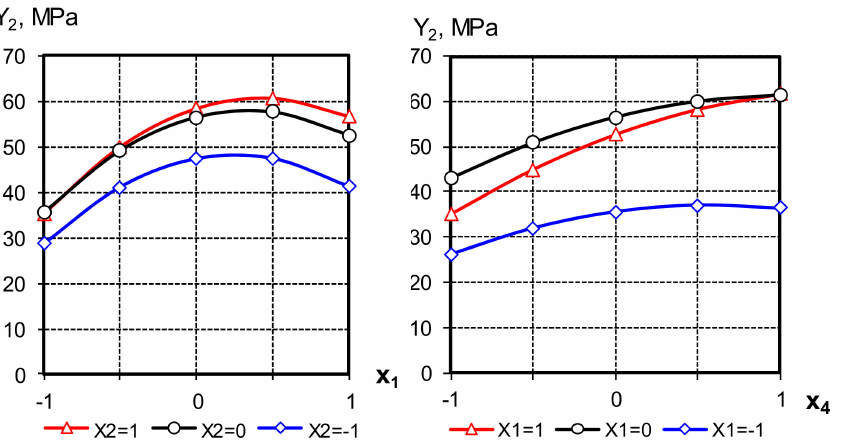
Figure 8. Graphical dependences of the variable factors on the cement strength